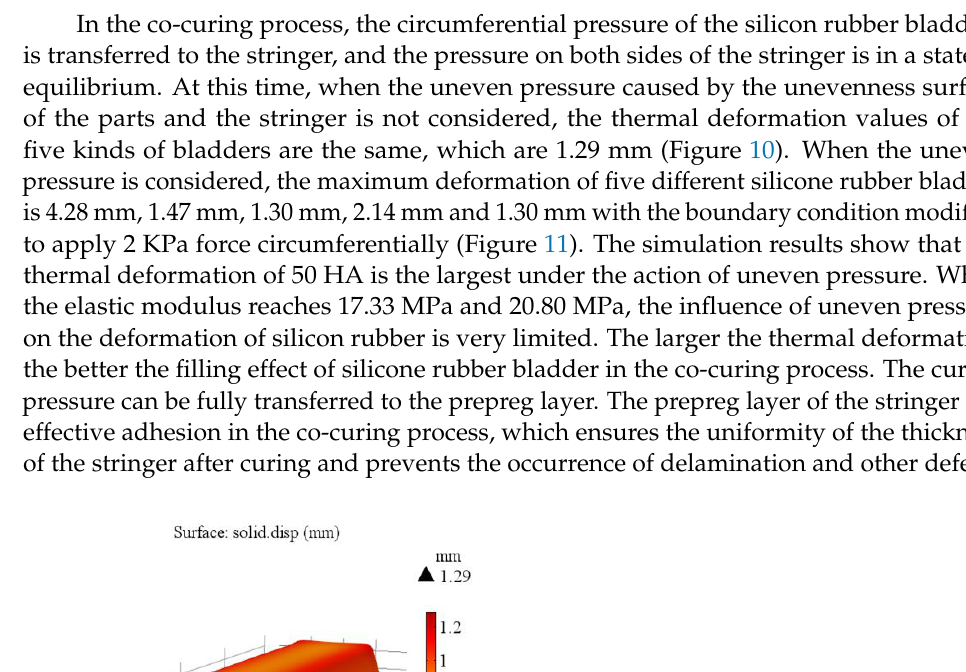
(e) Figure 11. Thermal deformation of different silicone rubber bladders considering uneven pressure: ( a ) 50 HA; ( b ) 50 HC; ( c ) 50 HD; ( d ) 70 HA; ( e ) 90 HA. In order to accurately obtain the influence of different filling bladders on the uni- formity of the skin-stringer thickness, the stiffened panel should be sectioned, and the